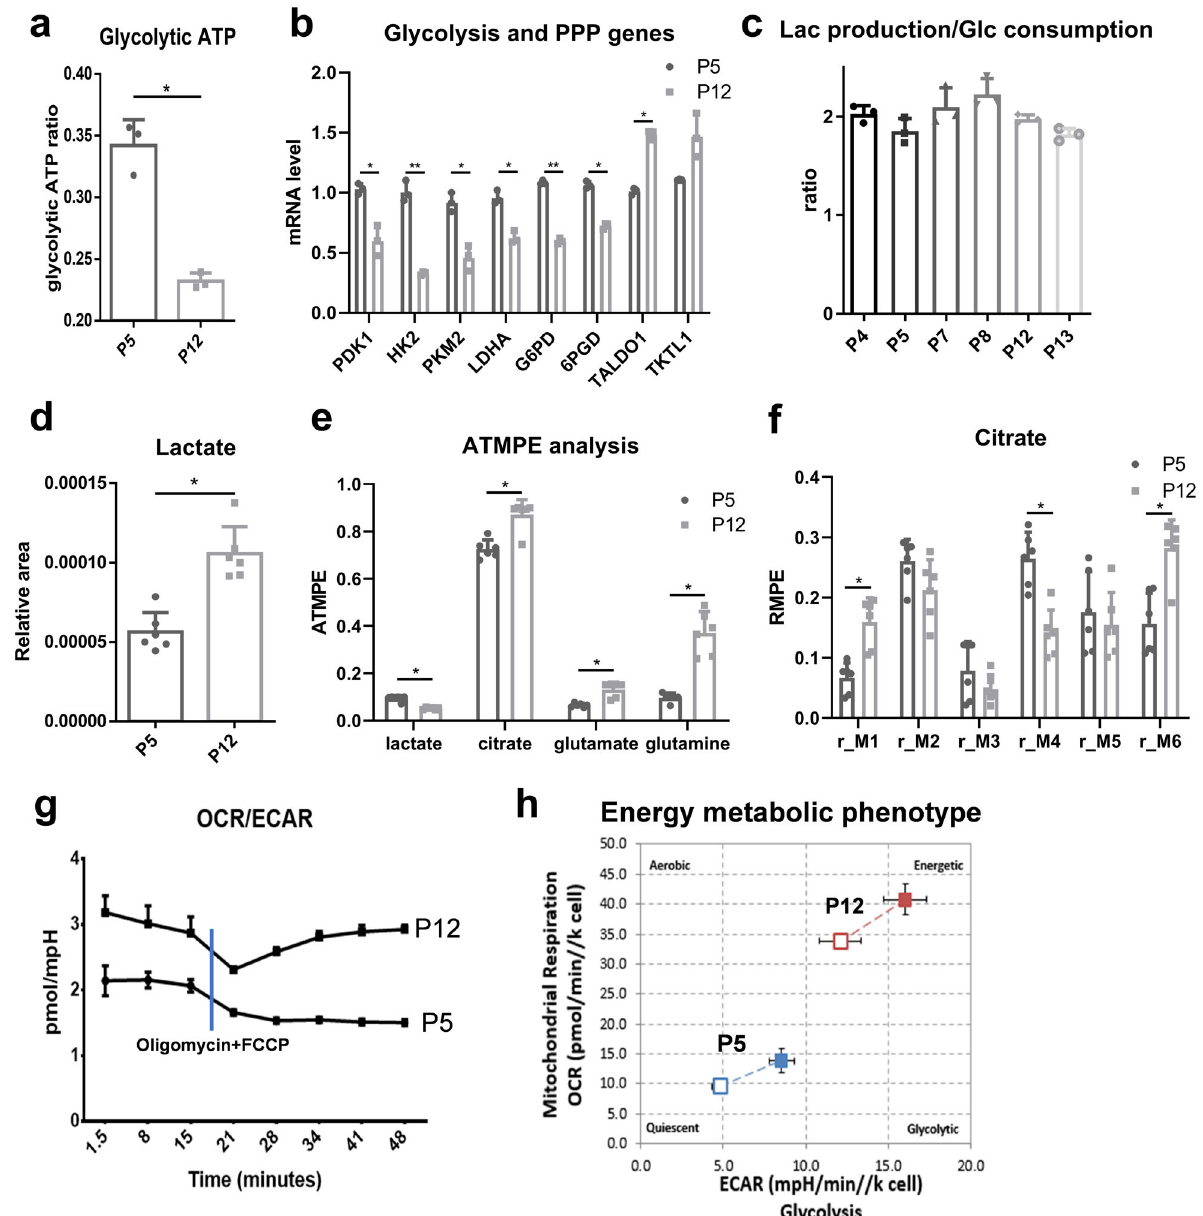
Fig. 3 Culture expansion induces human mesenchymal stem cell (hMSC) metabolic recon fi guration. a Glycolytic ATP ratio was decreased during culture expansion of hMSCs. b mRNA level of genes in glycolysis and pentose phosphate pathways (PPP) of hMSCs during culture expansion. c Lactate (Lac) production/glucose (Glc) consumption ratio of hMSCs during extensive expansion. Gas chromatography – mass spectrometry (GC – MS) analysis of hMSCs during culture expansion. d Internal normalized peak area of lactate. e Absolute total molar percent enrichment (ATMPE) levels of 13 C-glucose atoms in metabolites involved in glycolysis and OXPHOS. f The relative molar percent enrichment (RMPE) levels of citrate. g OCR/ECAR ratio changes with time of culture in hMSCs at early and late passage. h hMSC energy metabolic phenotype during culture expansion based on OCR and ECAR, open square: basal condition; closed square: stressed condition. Biological replicates ( n ): n = 6 for GC – MS metabolite study, n = 3 for rest of the tests. * p < 0.05; ** p <